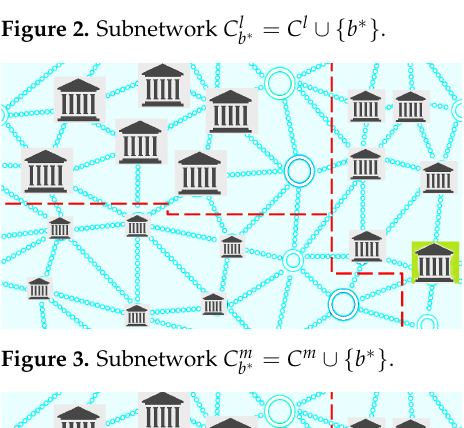
Figure 3. Subnetwork C m